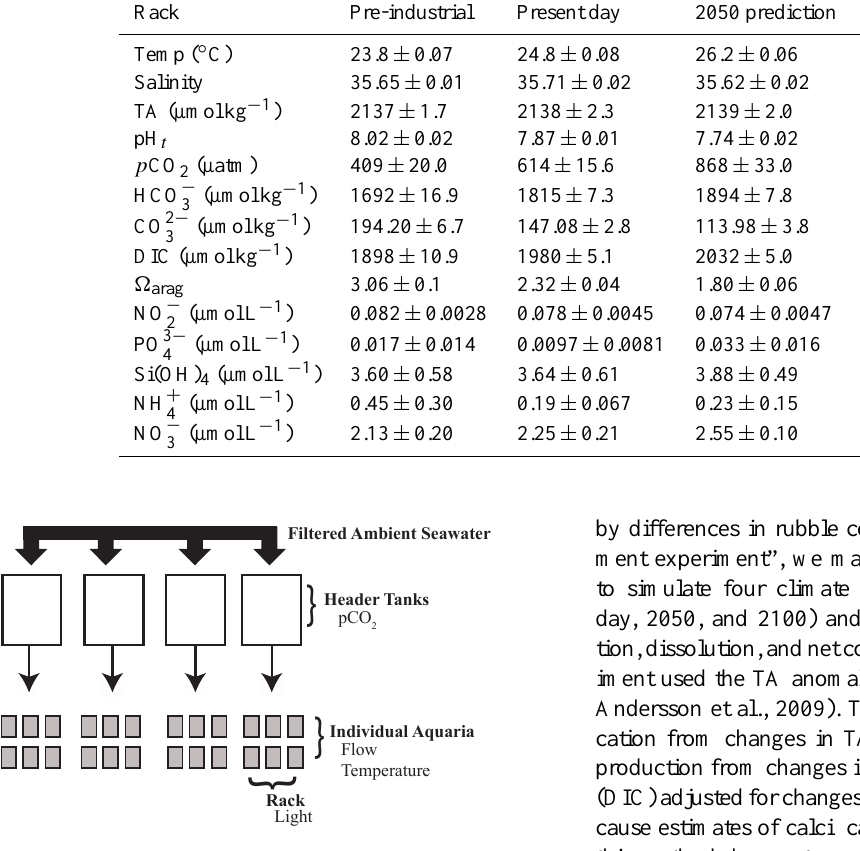
Figure 1. A schematic of the mesocosm system at the Hawaii Insti- tute of Marine Biology. Ambient seawater is pumped into the sys- tem from a nearby fringing reef in Kaneohe Bay. The seawater is filtered with a sand trap filter, passed through a water chiller and then fed into one of four header tanks. p CO 2 is manipulated in each header tank by bubbling a mixture of CO 2 -free air and pure CO 2 to the desired concentration. The water from one header tank flows into six aquaria (a rack). Light is controlled by a rack with metal-halide lights. There are two metal-halide lights per rack, with each light oscillating over a set of three aquaria. Flow and tempera- ture are controlled in each individual aquarium with flow valves and aquarium heaters and coolers,